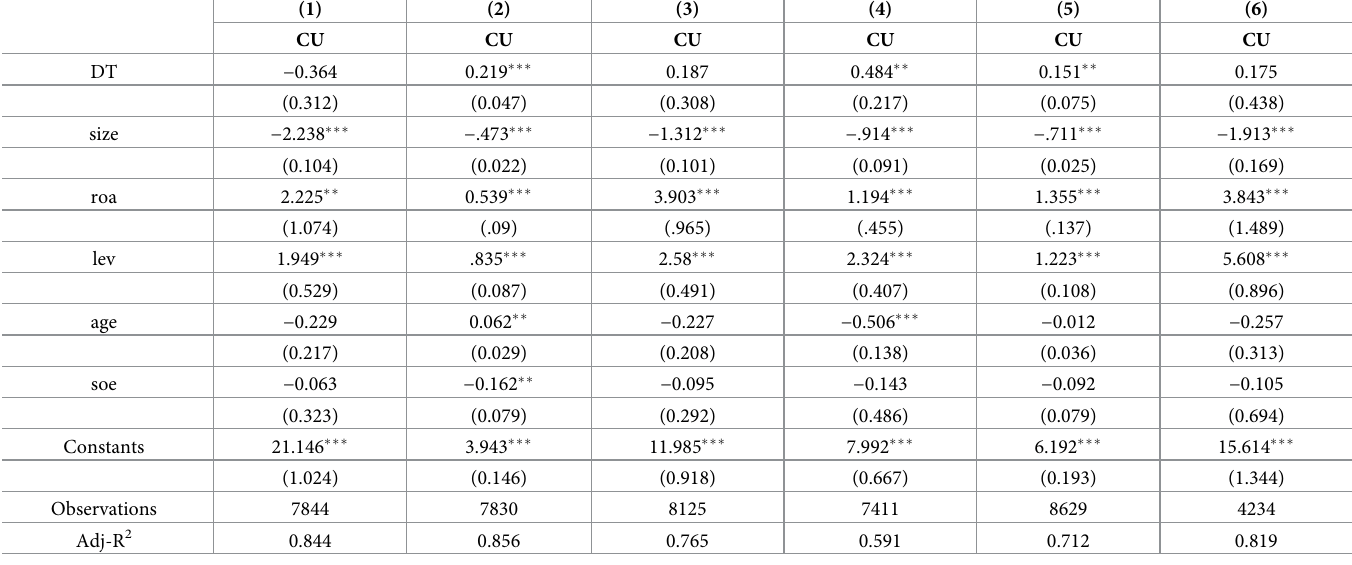
Table 6. Regression results of mechanism